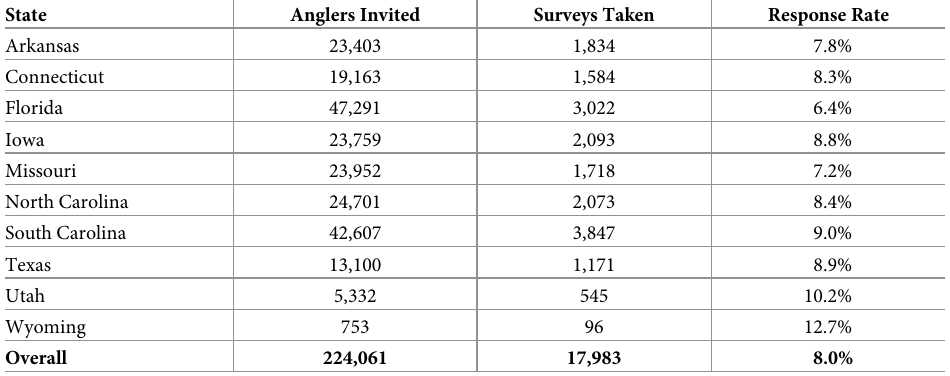
Table 1. States, number of anglers invited to participate in the survey, number of surveys taken, and response rate for a COVID-19